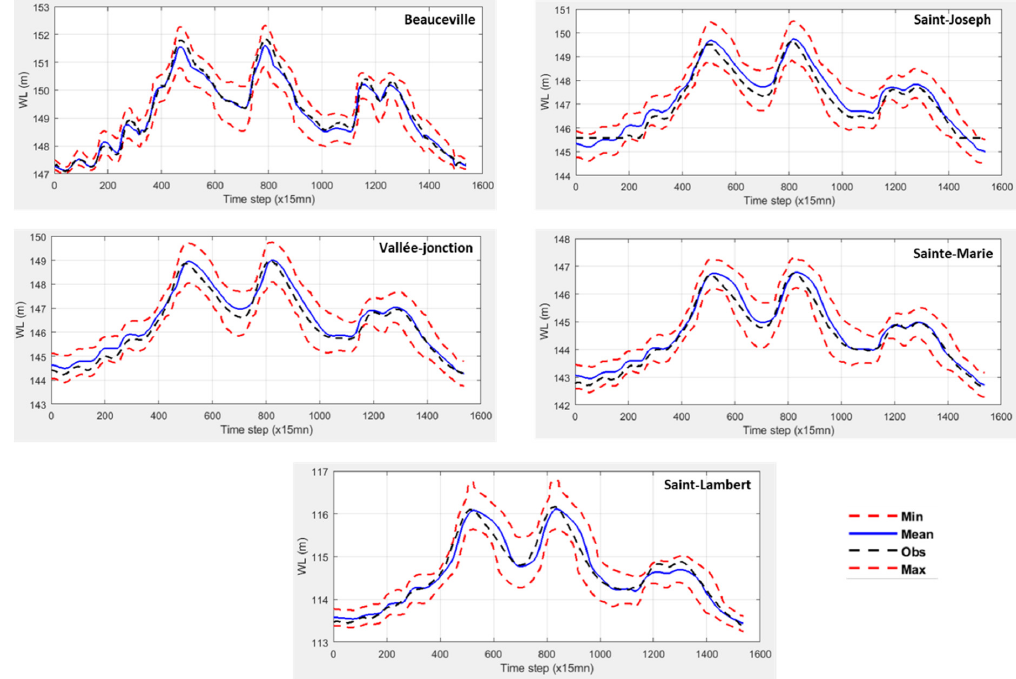
Figure A2. Water level ensembles vs. observations at each station—validation event V2.